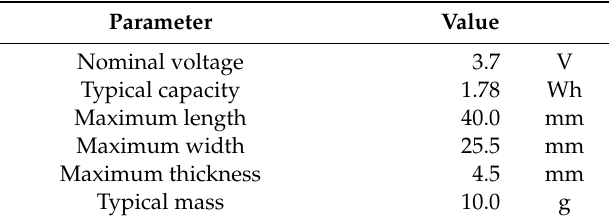
Table 2. Selected battery